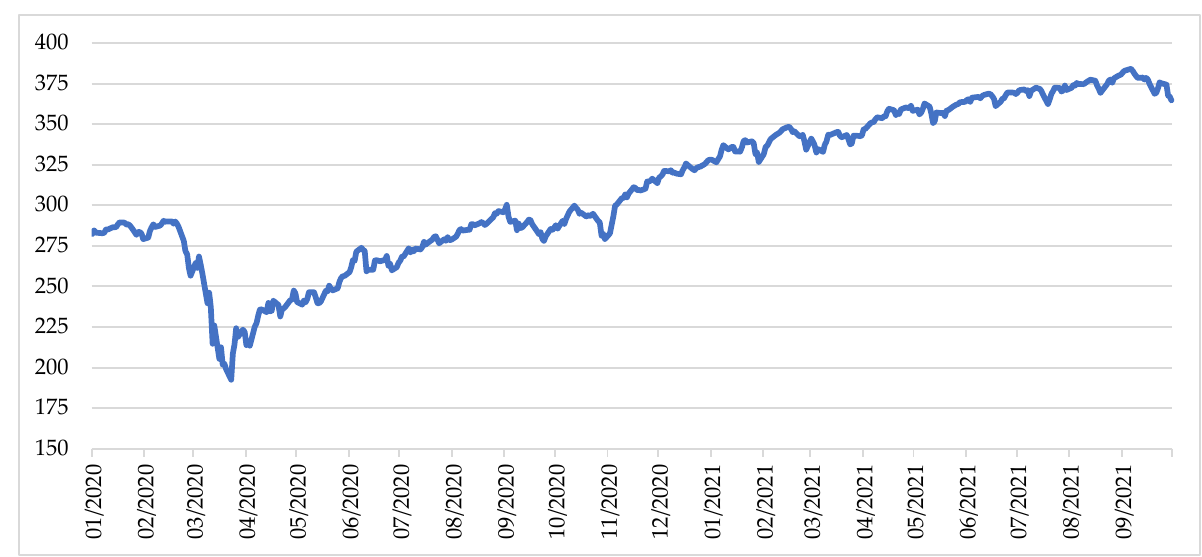
Figure 1. The MSCI ACWI Index performance in January 2020–September 2021. Source: Authors’ own calculations and elaborations based on Refinitiv Datastream.